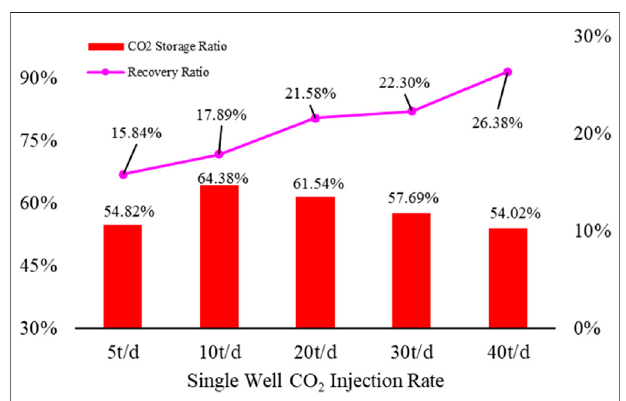
FIGURE 7 | Total CO 2 storage ratio under different injection rates.